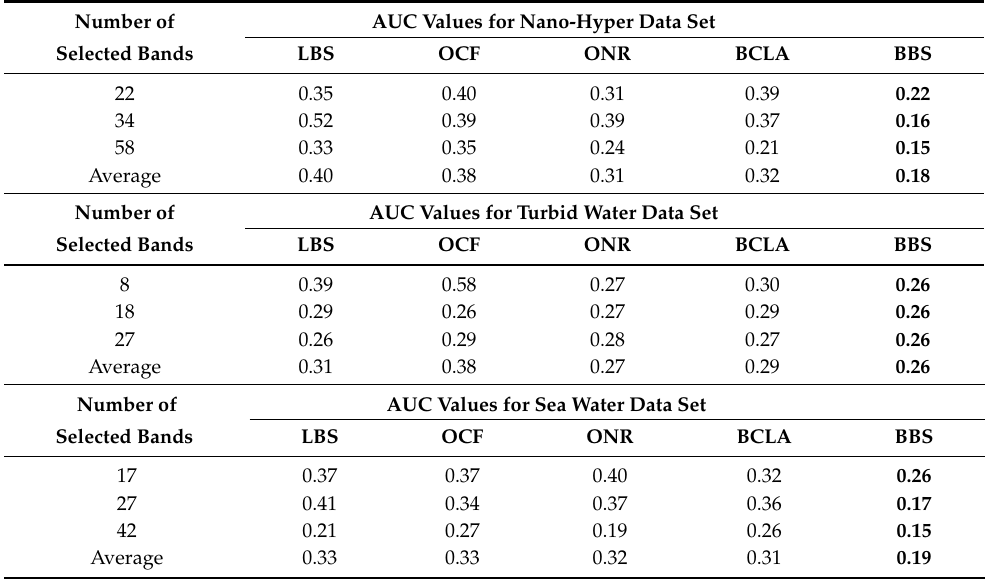
The bold entries represent the best performance in each